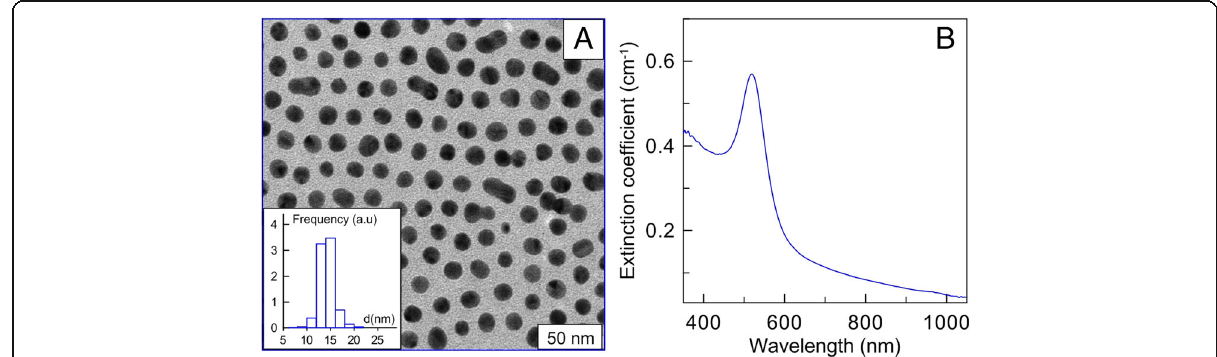
Fig. 1 Results of dark field electron microscopy, a image of 15 nm AuNPs (note –– diagram of the size distribution), b extinction spectra of 15 nm